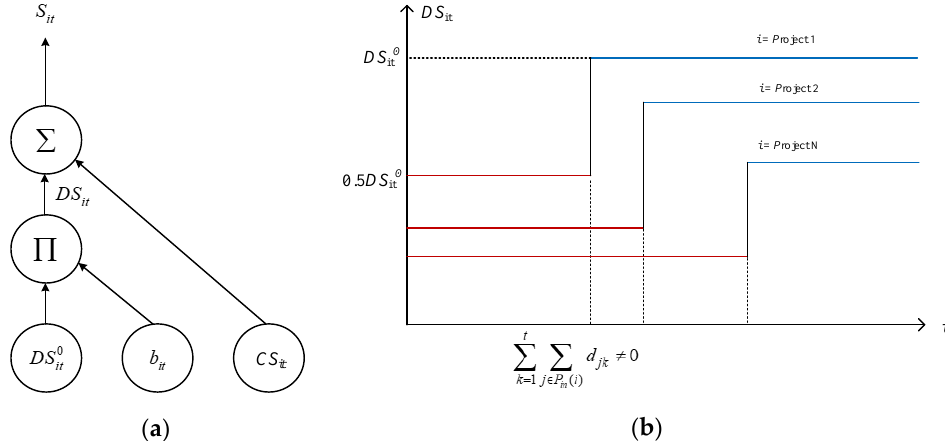
Figure 5. Comprehensive score of individual projects considering the interactions among projects: ( a ) Schematic diagram of the comprehensive score calculation; ( b ) The actual dominant condition score of individual projects.